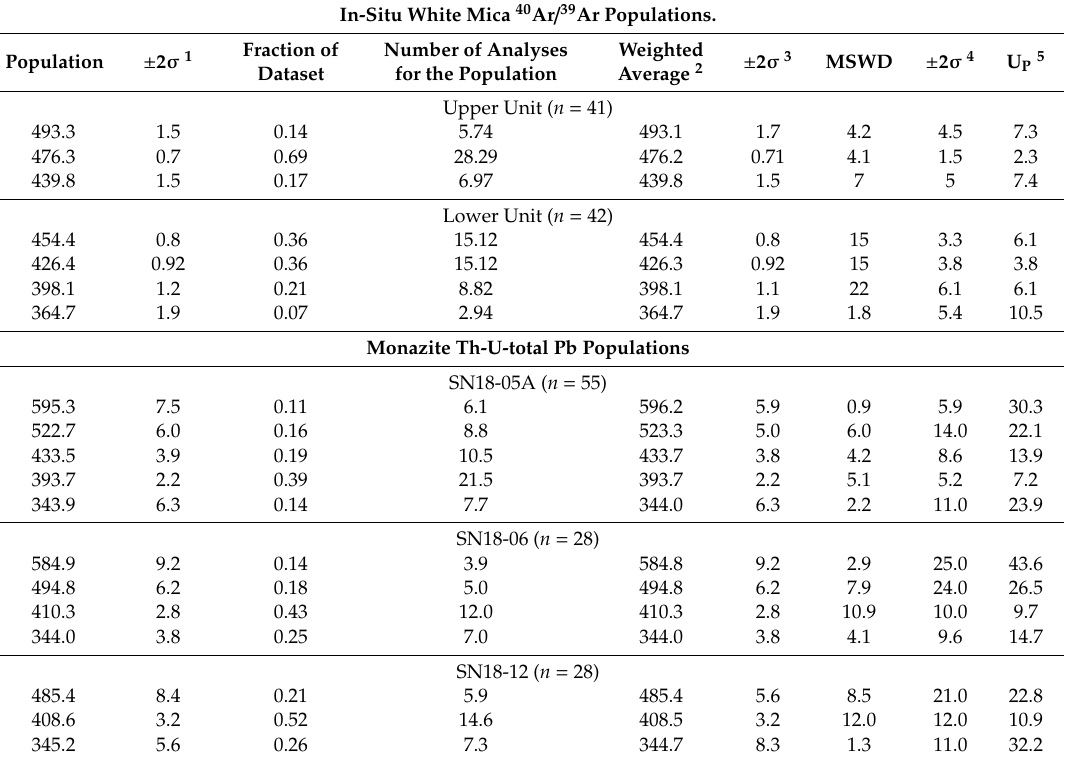
Table A1. Summary of population uncertainties. In-Situ White Mica 40 Ar / 39 Ar